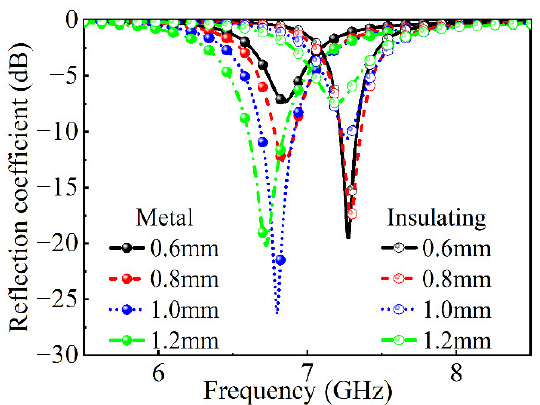
Figure 7. The reflection coefficient with the different thicknesses of the dielectric layer in the metal sate and in the insulating state.